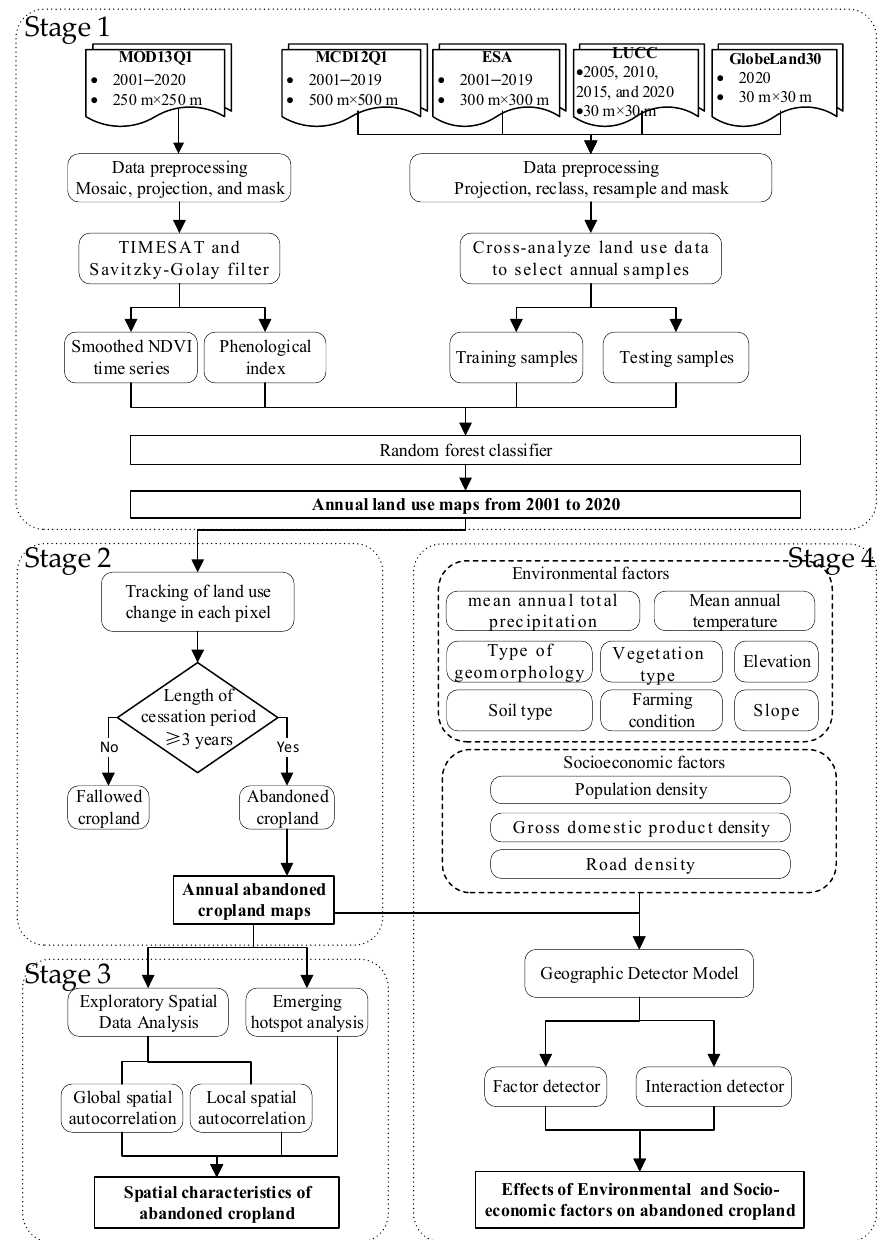
Figure 2. Flow charts showing abandoned cropland patterns and influencing factor analysis process.